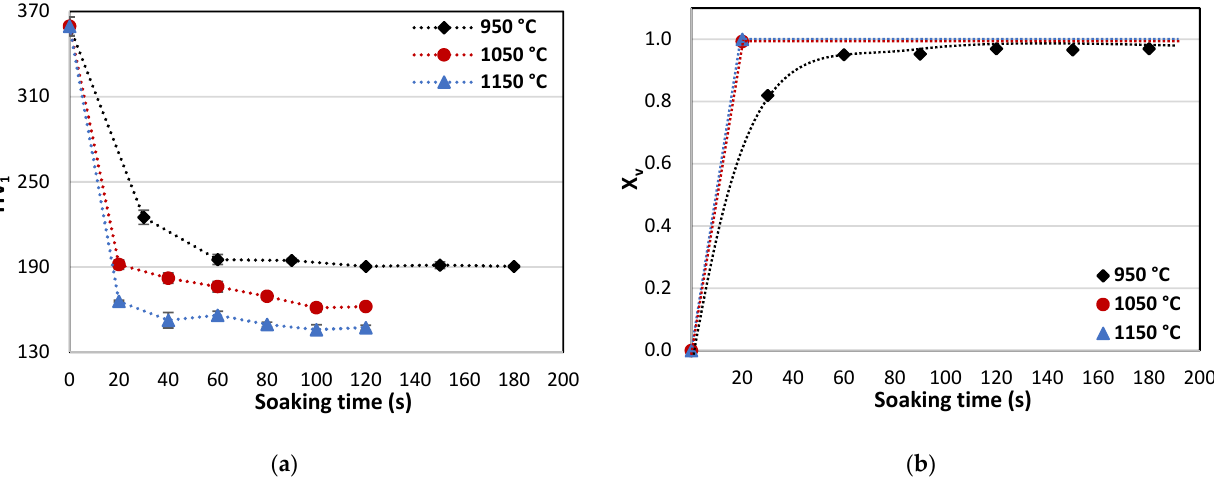
Figure 10. Effects of process parameters (temperature and soaking time) on hardness values HV 1 ( a ) and recrystallized volume fraction X v ( b ) of AISI 904L cold-rolled at 80%.